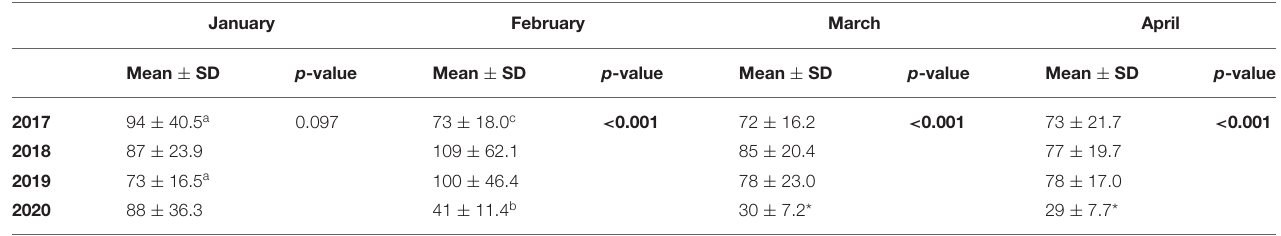
TABLE 1 | Comparison of ED visits per day during the period of January to April from 2017–2020 at Kaohsiung Chang Gung Memorial